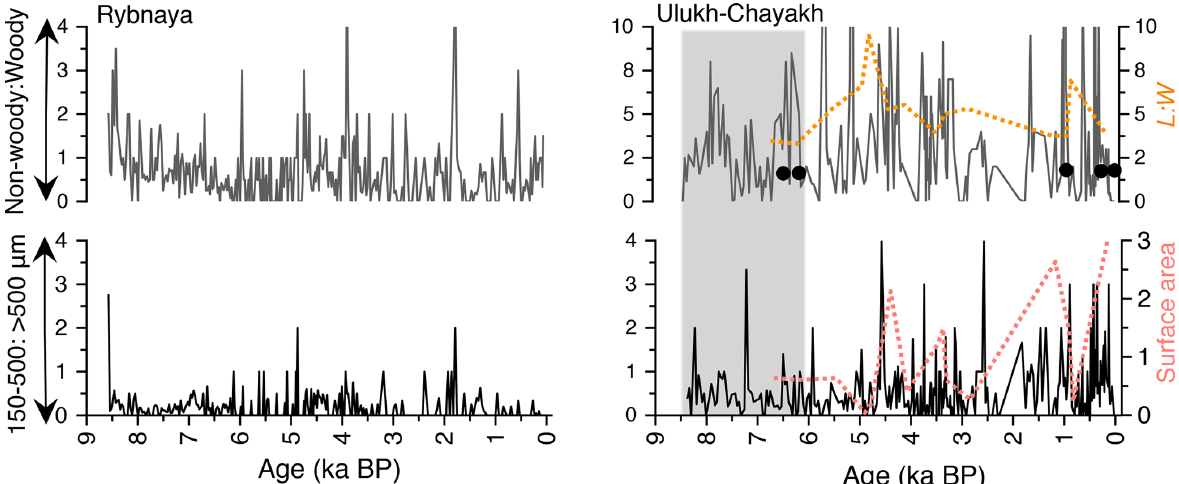
Figure 2. The ratio of charcoal morphotype influx (particlescm − 2 yr − 1 ) of the two main categories: woody (wood, deciduous leaves, resins) and non-woody type (forbs, grass) in the Rybnaya and Ulukh–Chayakh sequences. The aspect ratio ( L : W ) at Ulukh–Chayakh is used for fuel type identification. A high L : W ratio is typical for a higher abundance of graminoid charcoal, whereas a lower L : W ratio is typical for charcoal from wood and leaves. The ratio of charcoal influx (particlescm − 2 yr − 1 ) of the two main size classes is as follows: small 150– 500µm and large > 500µm in the two sequences and the charcoal surface area (µm 2 ) at Ulukh–Chayakh (see Sect. S3 for a full range of size classes). Bullets at Ulukh–Chayakh represent the extra-large charcoal fraction ( > 1000µm) identified during routine plant macrofossil analysis of sediment volumes of ca. 20cm 3 . The grey time window highlights the period with an uncertain chronology. Note that some high-amplitude charcoal peaks have been truncated to enhance the visibility of long-term trends in charcoal